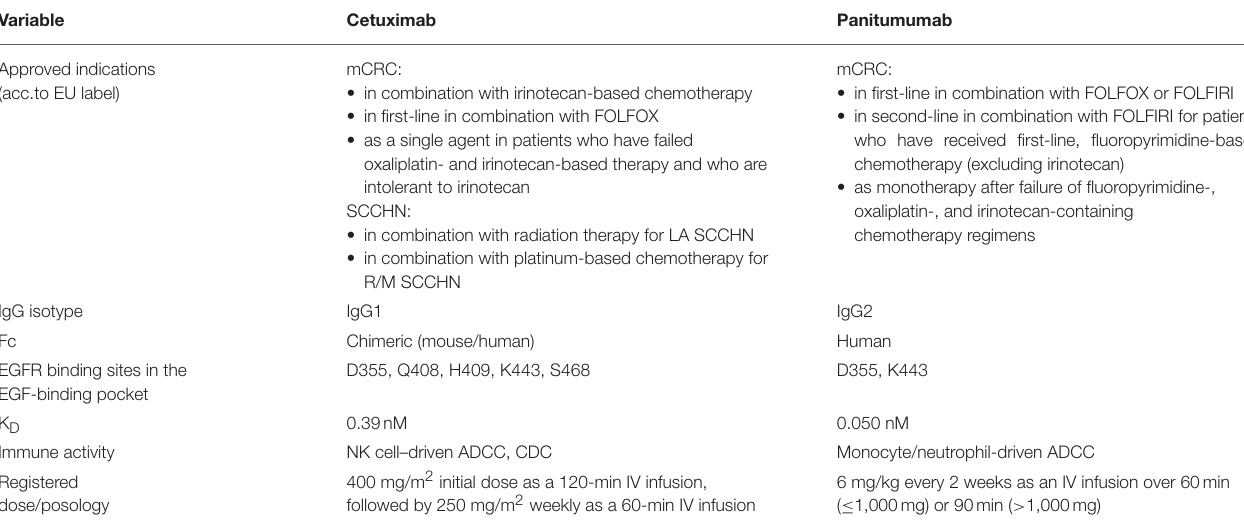
TABLE 1 | Basic comparison of cetuximab and panitumumab.